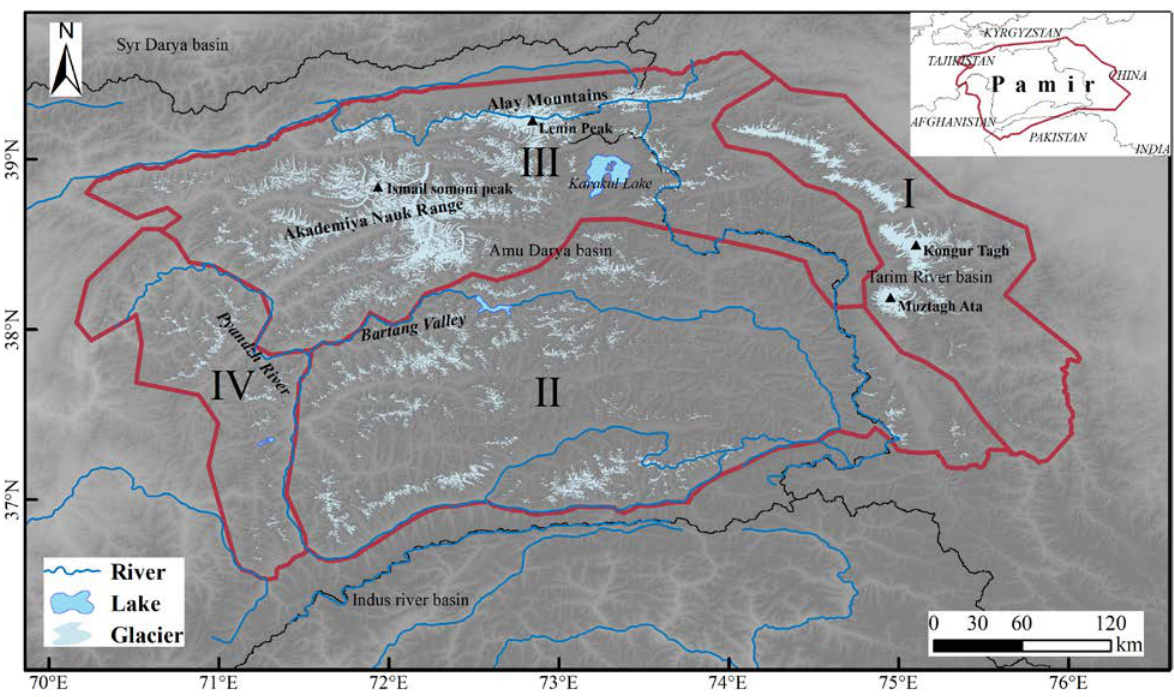
Figure 1. General situation and distribution of glaciers in the Pamir study area. NASADEM was used as the background.